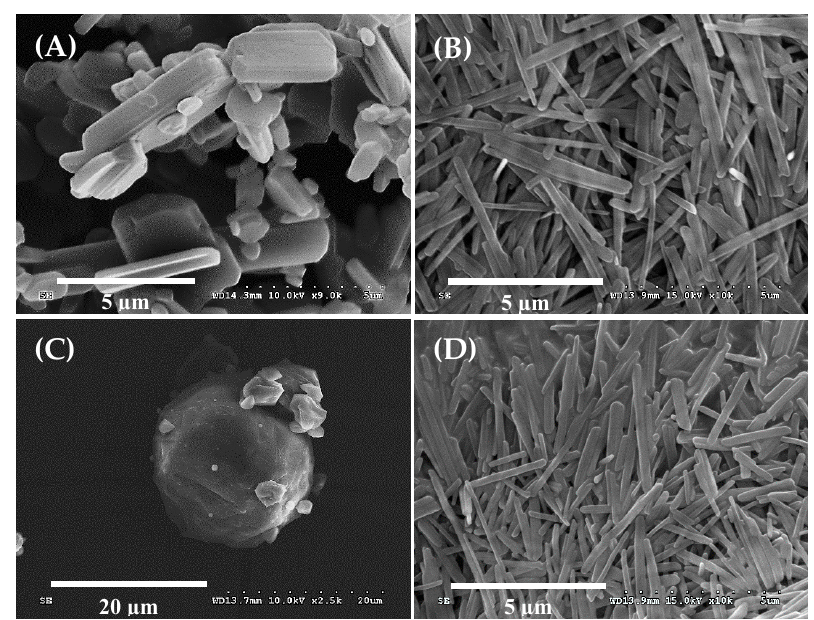
Figure 1. SEM images of ( A ) celecoxib (CXB) powder, ( B ) Nanosuspension, ( C ) reconstitutable dry suspension (RDS), and ( D ) Reconstituted RDS in aqueous solution.